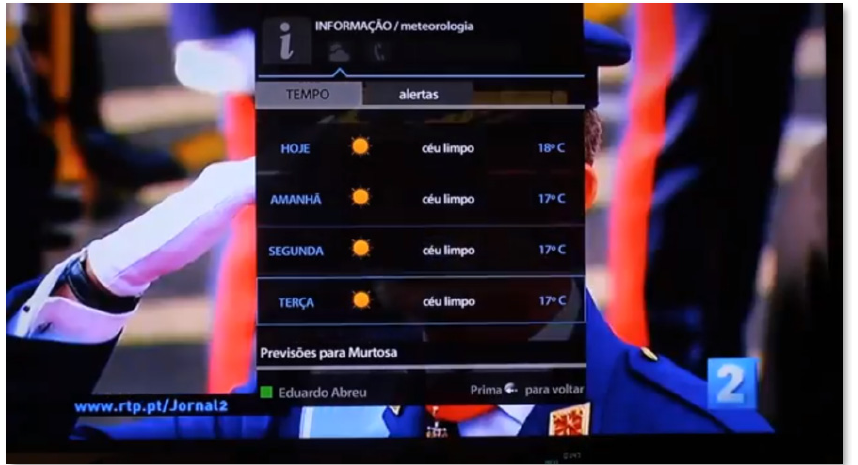
Figure 9. Information area of the SecurHome TV application.